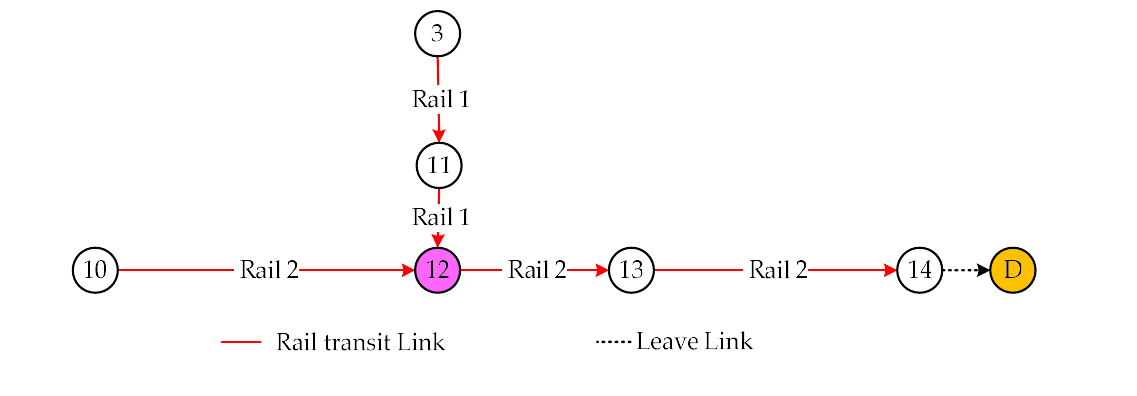
Figure 5. The routes of the rail transit network. Table 3. The information of rail transit routes.